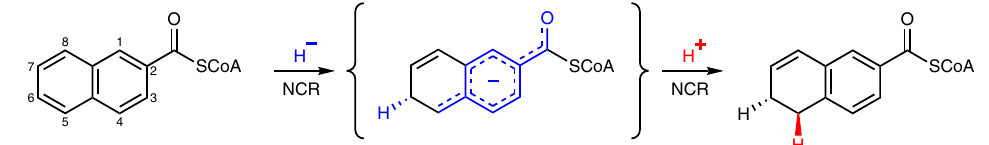
Fig. 1 Stereochemical course and potential hydride transfer mechanism of NCR. The enantioselective hydride (blue) and proton (red) transfers are